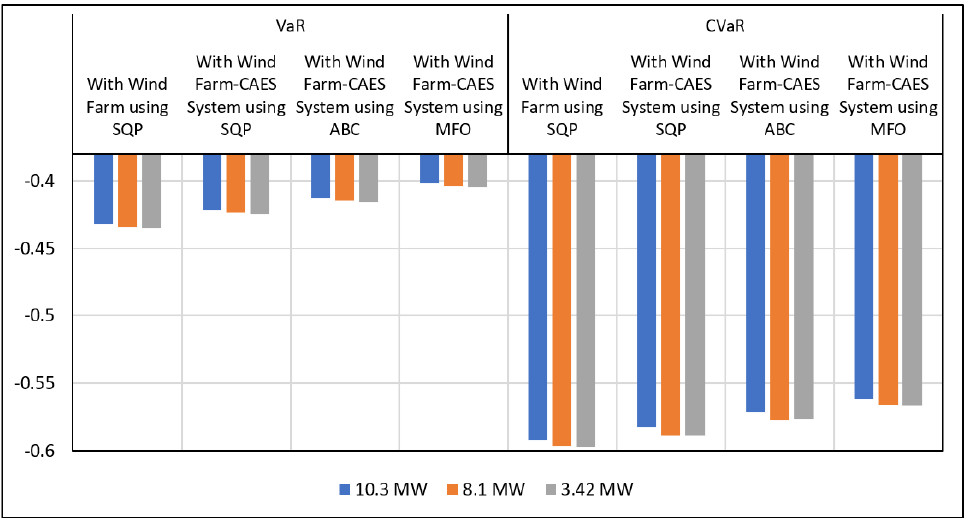
Figure 13. System risk with different optimization techniques for Delhi with different system con- ditions.